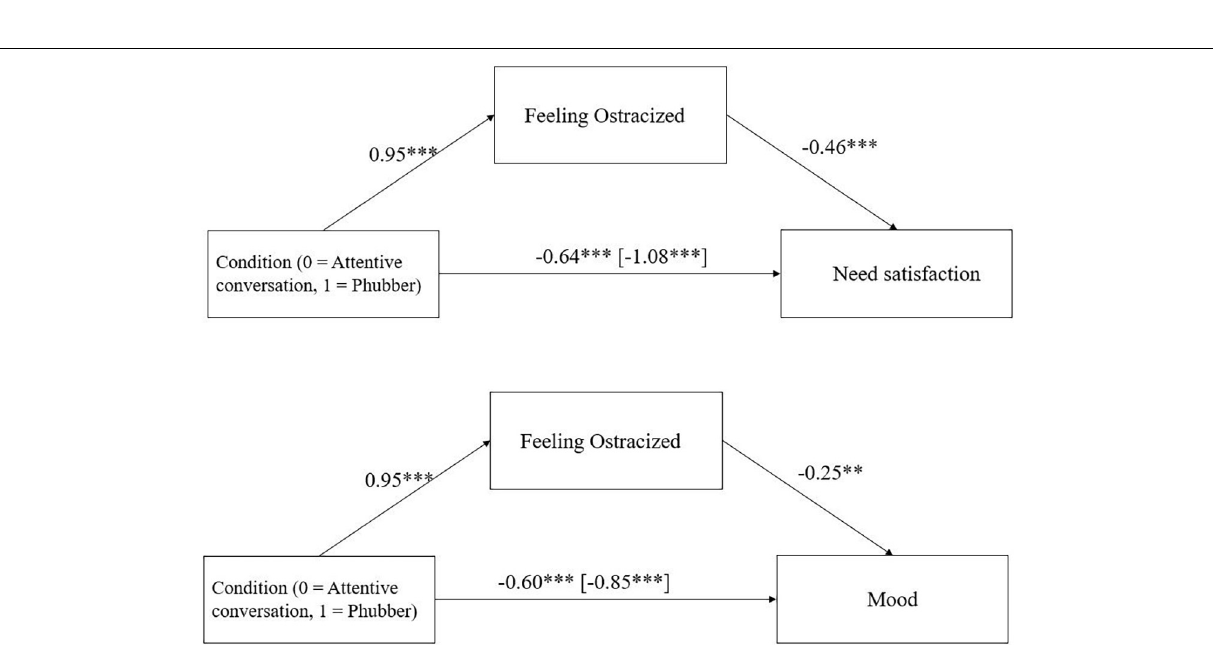
Frontiers in Psychology |